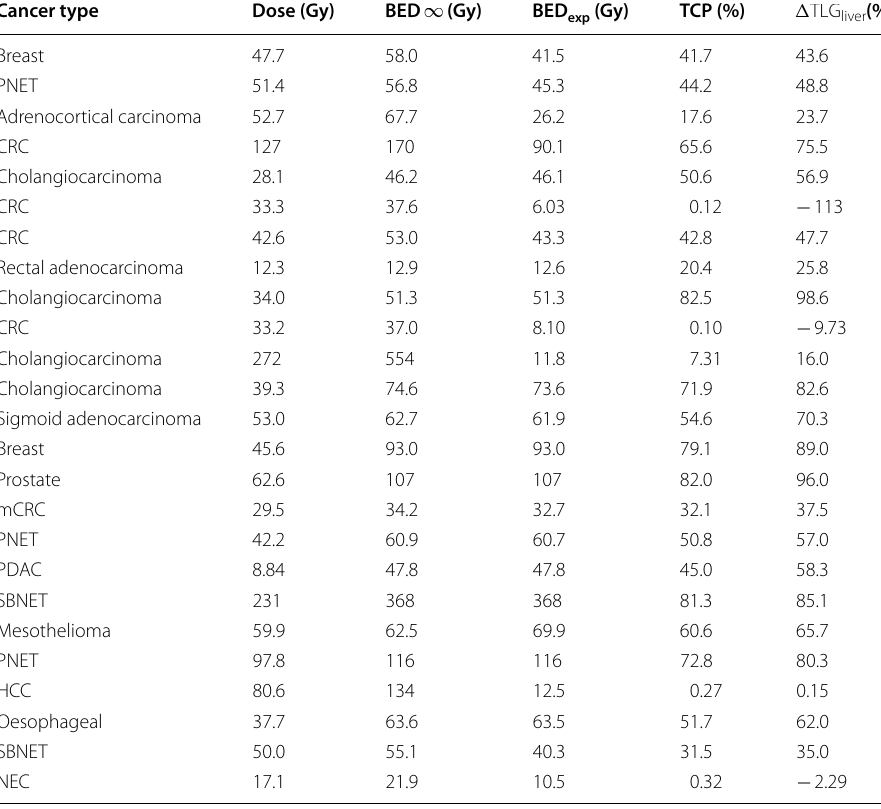
Table 3 Summary of computed dosimetry